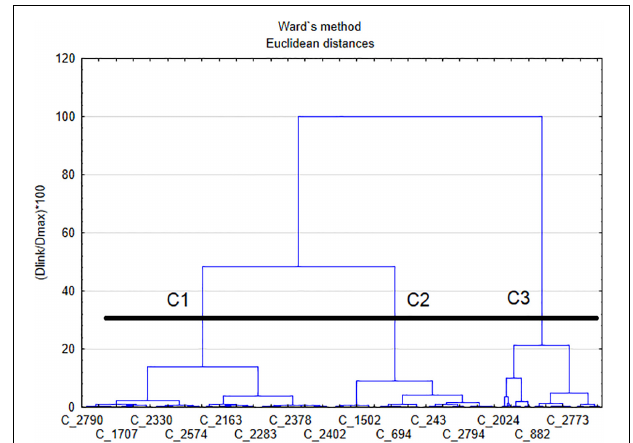
FIGURE 2 | The dendrogram of the data points used in the work. The data are clustered into three groups: C1, C2, and C3. The x -axis represents measured air quality and meteorological data vectors, and the y -axis is the distance between points. The horizontal line represents the threshold distance between clusters we used in the work, and C_ denotes